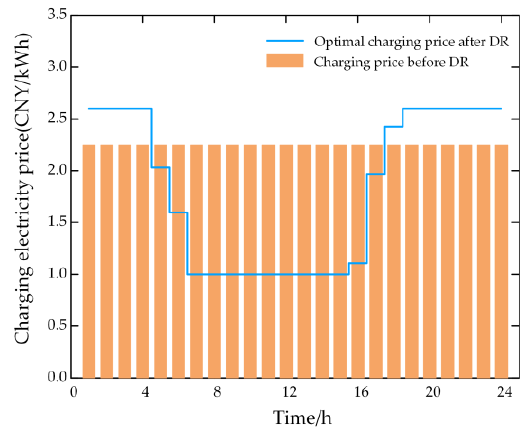
Figure 9. Optimal charging price scheme after considering DR.